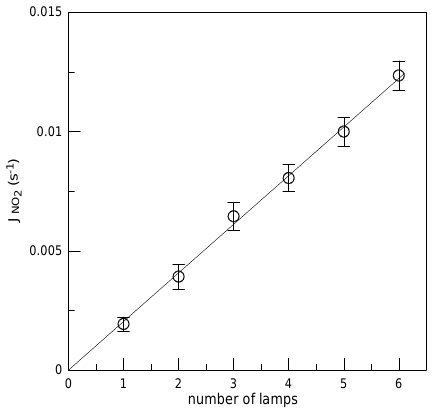
) as a function of the Fig. 3. Examples of kinetics of NO 2 consumption on TiO 2 surface: 2 T = 300K, sample mass = 0.3 mgcm − 1 , J NO cles: initial uptake, P = 1Torr, [NO 2 ]=3.3 × 10 12 moleculecm − 3 , flow velocity=420cms − 1 ; squares: P = 9Torr, exposure time=150 min, [NO 2 ]=1.5 × 10 12 moleculecm − 3 , flow veloc- ity=42cms − 1 .